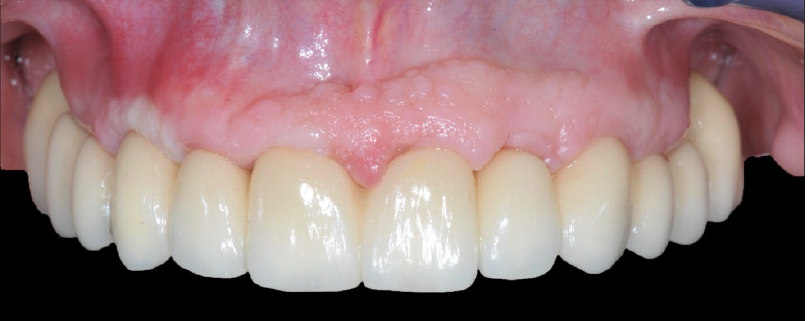
Figure 10. Cubic zirconia monolithic full arch assembled on a titanium framework with a model-free digital workflow was delivered (frontal view).